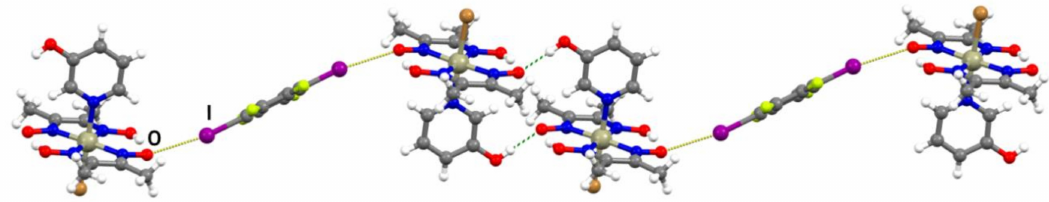
Figure 4. Halogen-bonded units of ( II ) 2 ( 14tfib ) interconnected by O–H ··· O hydrogen-bonded homosynthons into a